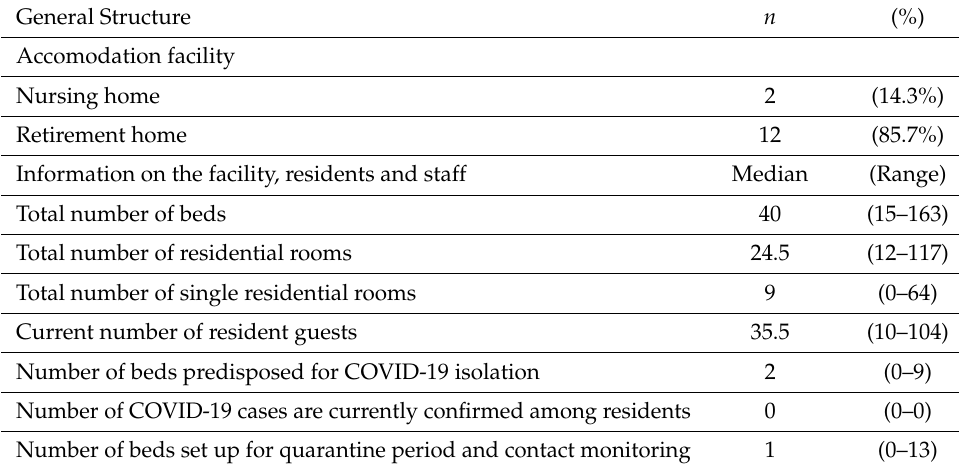
Table 4. Results of the introductory questionnaire ( N =